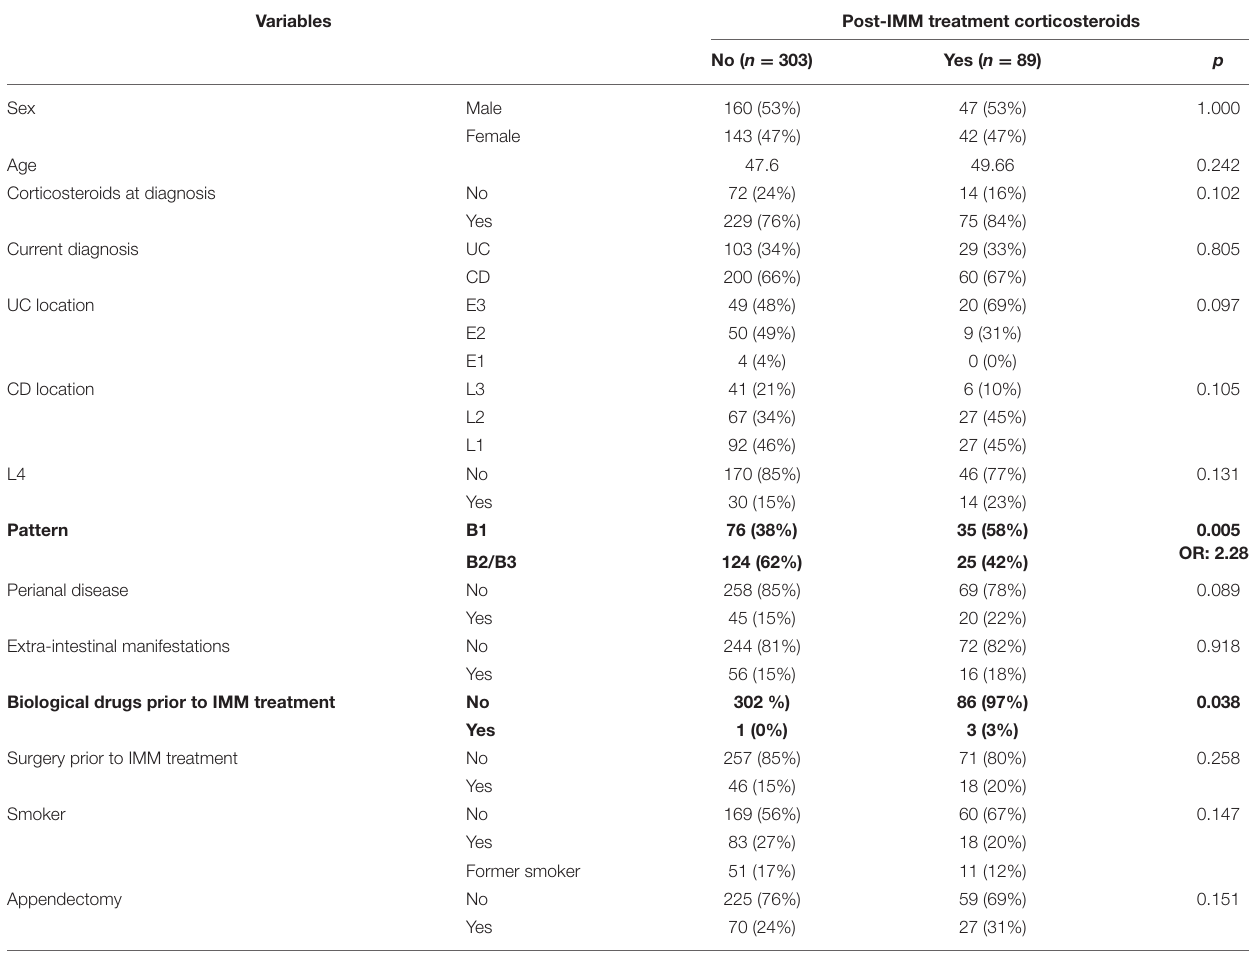
TABLE 3 | Variables associated with the need for treatment with corticosteroids in patients who have received at least 6 months of immunosuppressant treatment.